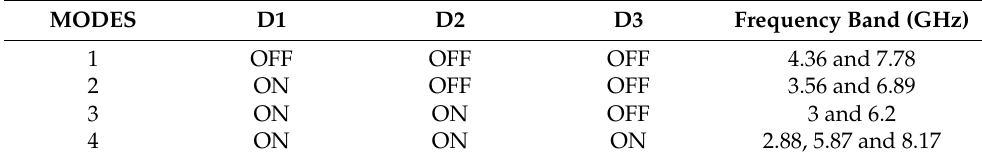
Table 2. The proposed antenna tuning states.